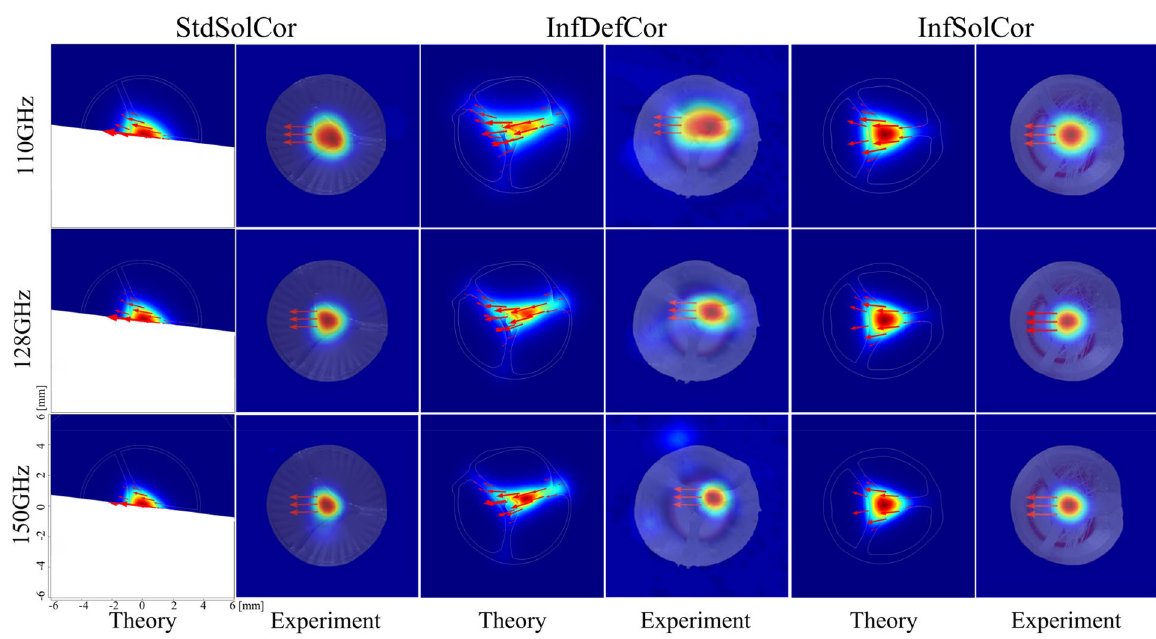
Figure 6. Comparison of the theoretically and experimentally measured electric field distributions of the X-polarized and X-like modes of the StdSolCor (0.25 m), InfDefCor (0.75 m), and InfSolCor (1.6 m). Electric field directions are shown as red arrows. In experimental measurements, electric field direction is defined by the orientation of the WR-6 waveguide flange, which is